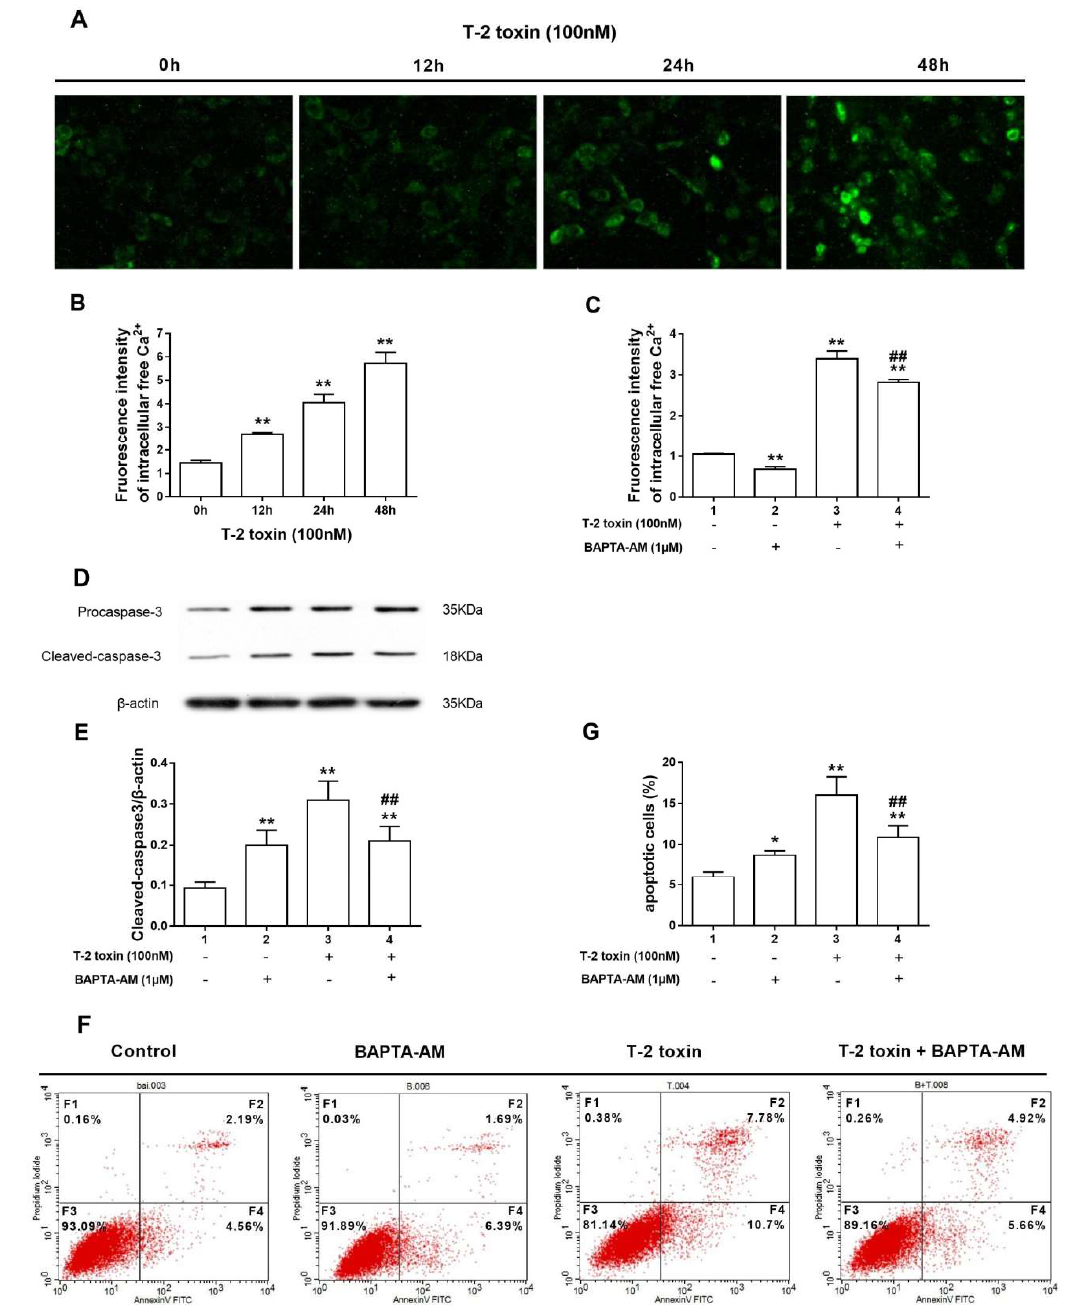
Figure 3. Induction of Ca 2+ is involved in T-2 toxin-mediated TM3 cell apoptosis. ( A ) Representative images of the fluorescence intensity of intracellular free Ca 2+ measured with Fura-2/AM, images were captured at 200× magnification. ( B ) T-2 toxin induced an increase in the free Ca 2+ intracellular concentration in a time-dependent manner. ( C ) BAPTA-AM pretreatment attenuated the increase of free Ca 2+ intracellular concentration. ( D ) Expression of cleaved-caspase-3 was analyzed by Western blot assay. ( E ) Level of cleaved-caspase-3 was quantified by densitometry. ( F ) Apoptosis was analyzed by Annexin V/PI assays in TM3 cells. ( G ) Percentage of apoptotic cells treated with T-2 toxin and (or) BAPTA-AM. BAPTA-AM attenuated the increase of percentage of apoptotic cells caused by treatment with T-2 toxin. * indicates p < 0.05 and ** indicates p < 0.01 when compared with the control group. ## indicates p < 0.01 when the co-treated group is compared with the group only treatment with T-2 toxin. Each experiment was performed and repeated at least three times.